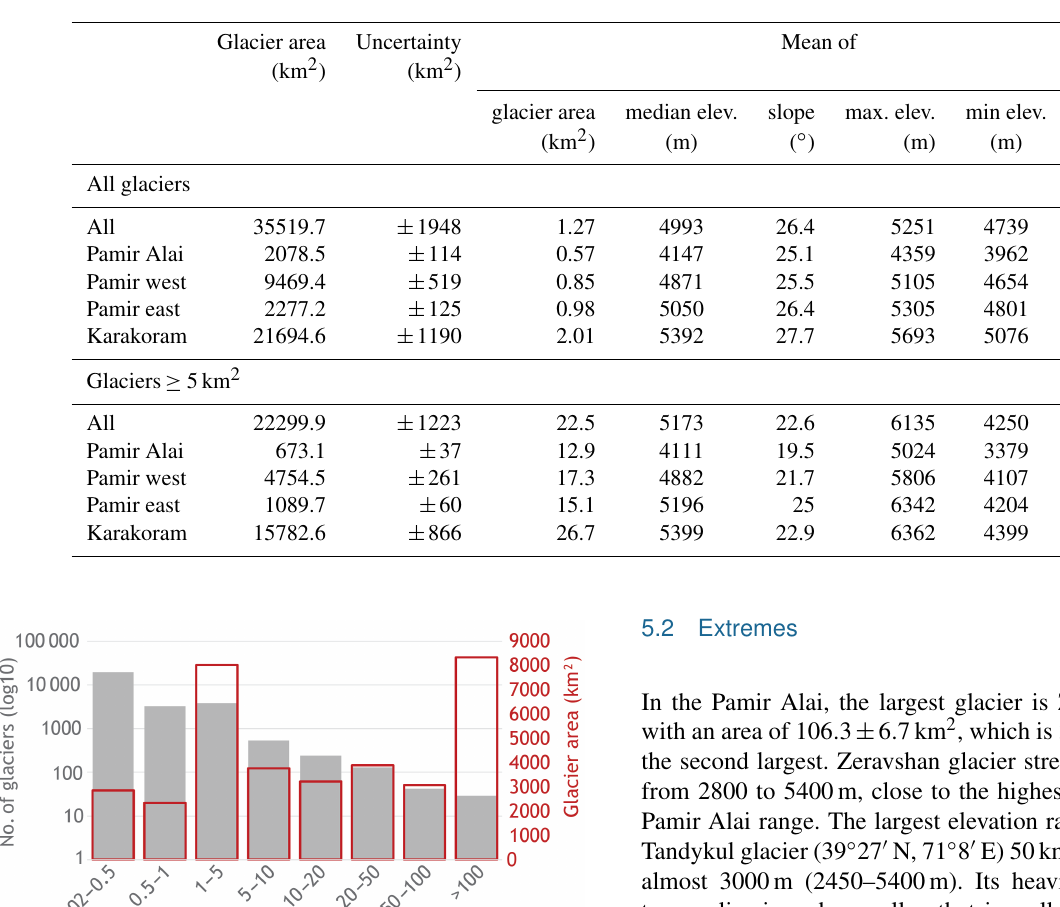
Table 3. The upper table shows the basic inventory statistics for all glaciers, with the lower table only showing the basic inventory statistics for glaciers larger than 5km 2 .